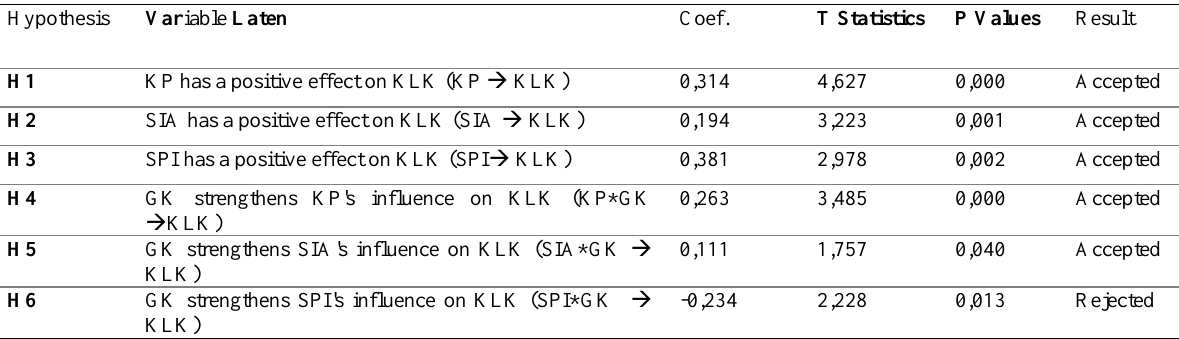
Table 4: Hypothesis Test